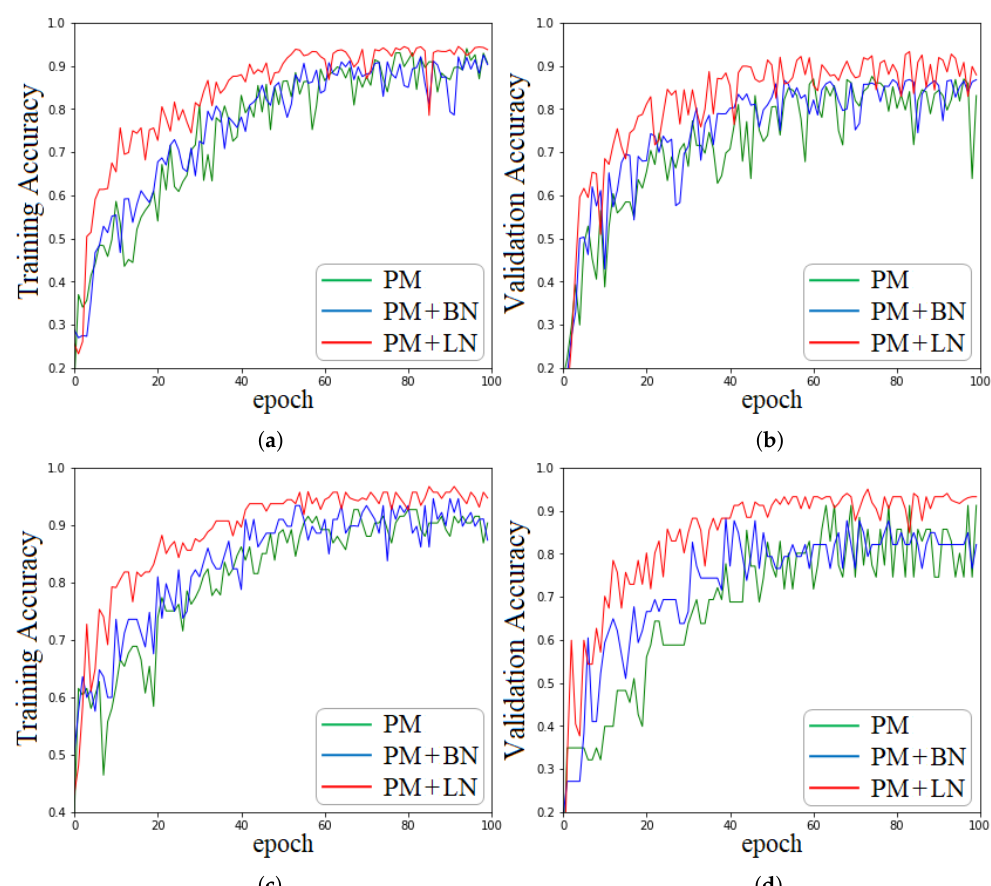
Figure 7. Comparison between results of the Proposed Model (PM), Proposed Model + Batch Normalization (PM+BN), and Proposed Model + Layer Normalization (PM+LN). ( a ) training curves of classifier model; ( b ) validation curves of classifier model; ( c ) training curves of controller model; ( d ) vvalidation curves of the controller